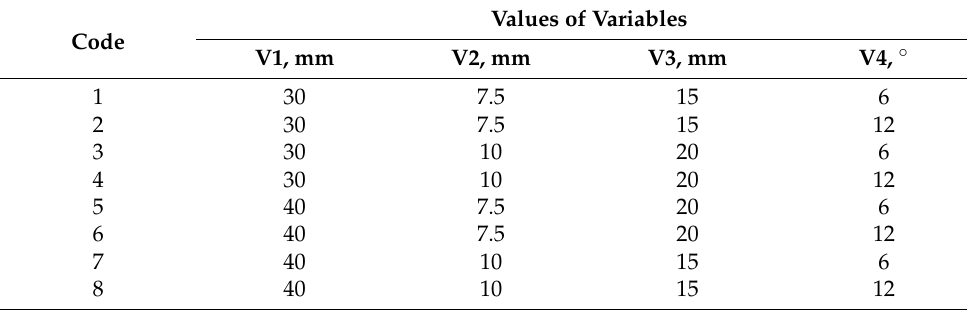
Table 1. Research design using the Taguchi